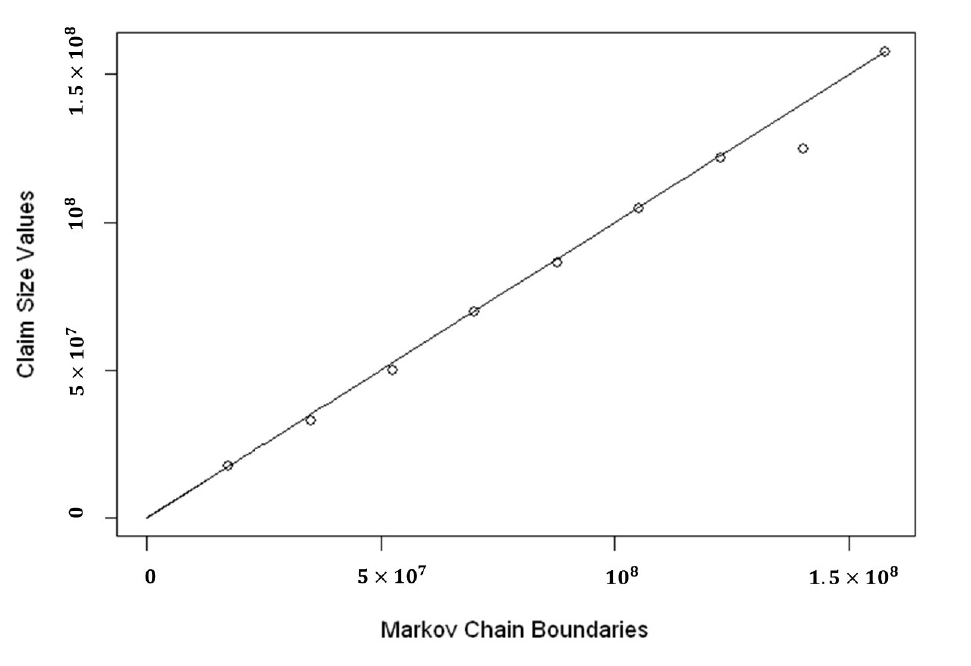
Figure 12. QQ-plot of Markov Chain claim boundaries and empirical claims in the boundaries for Group 1.